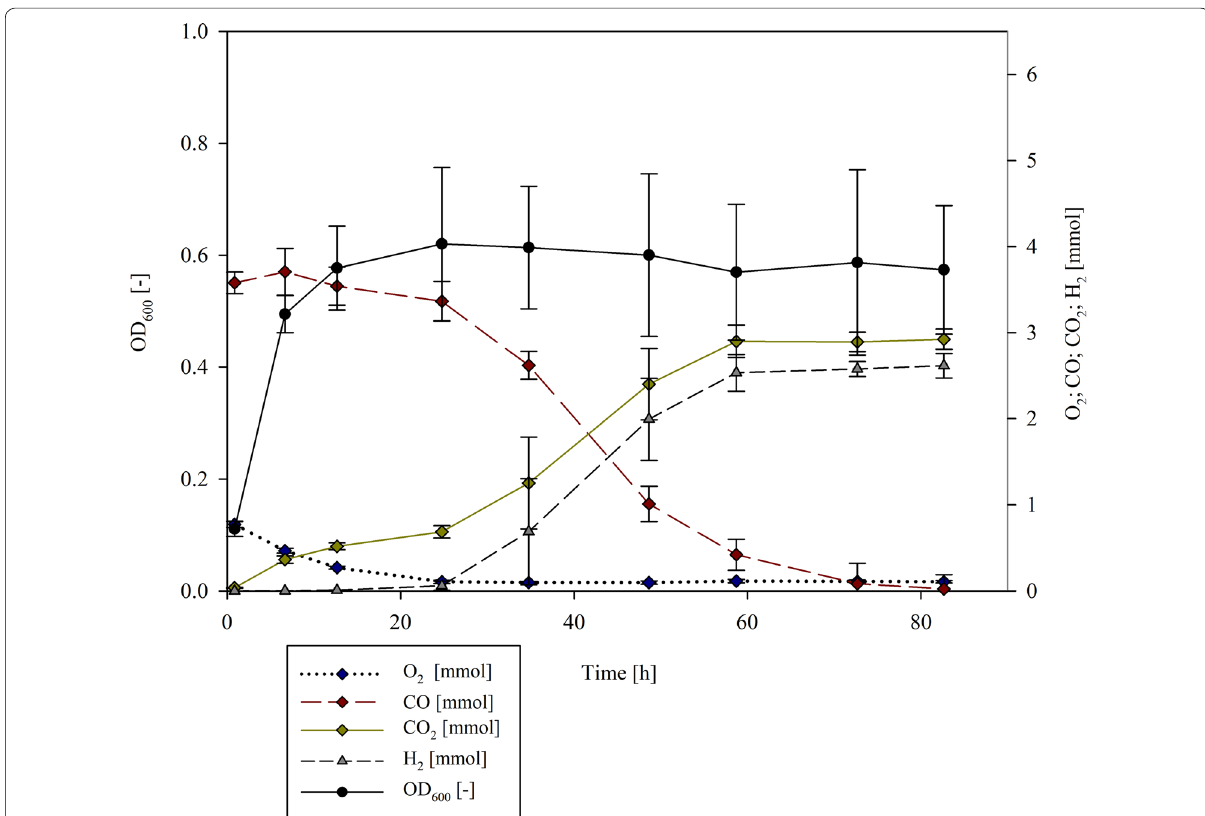
Fig. 1 Growth curve and gas composition during the cultivation of P. thermoglucosidasius DSM 6285 in the control set up (60 °C, pH 7.0, addition of 0.04 mM FeSO 4 7H 2 O, 50:50 initial gas atmosphere CO:air ratios, 12 h incubation time of the 2nd pre-culture, 2% inoculum ·